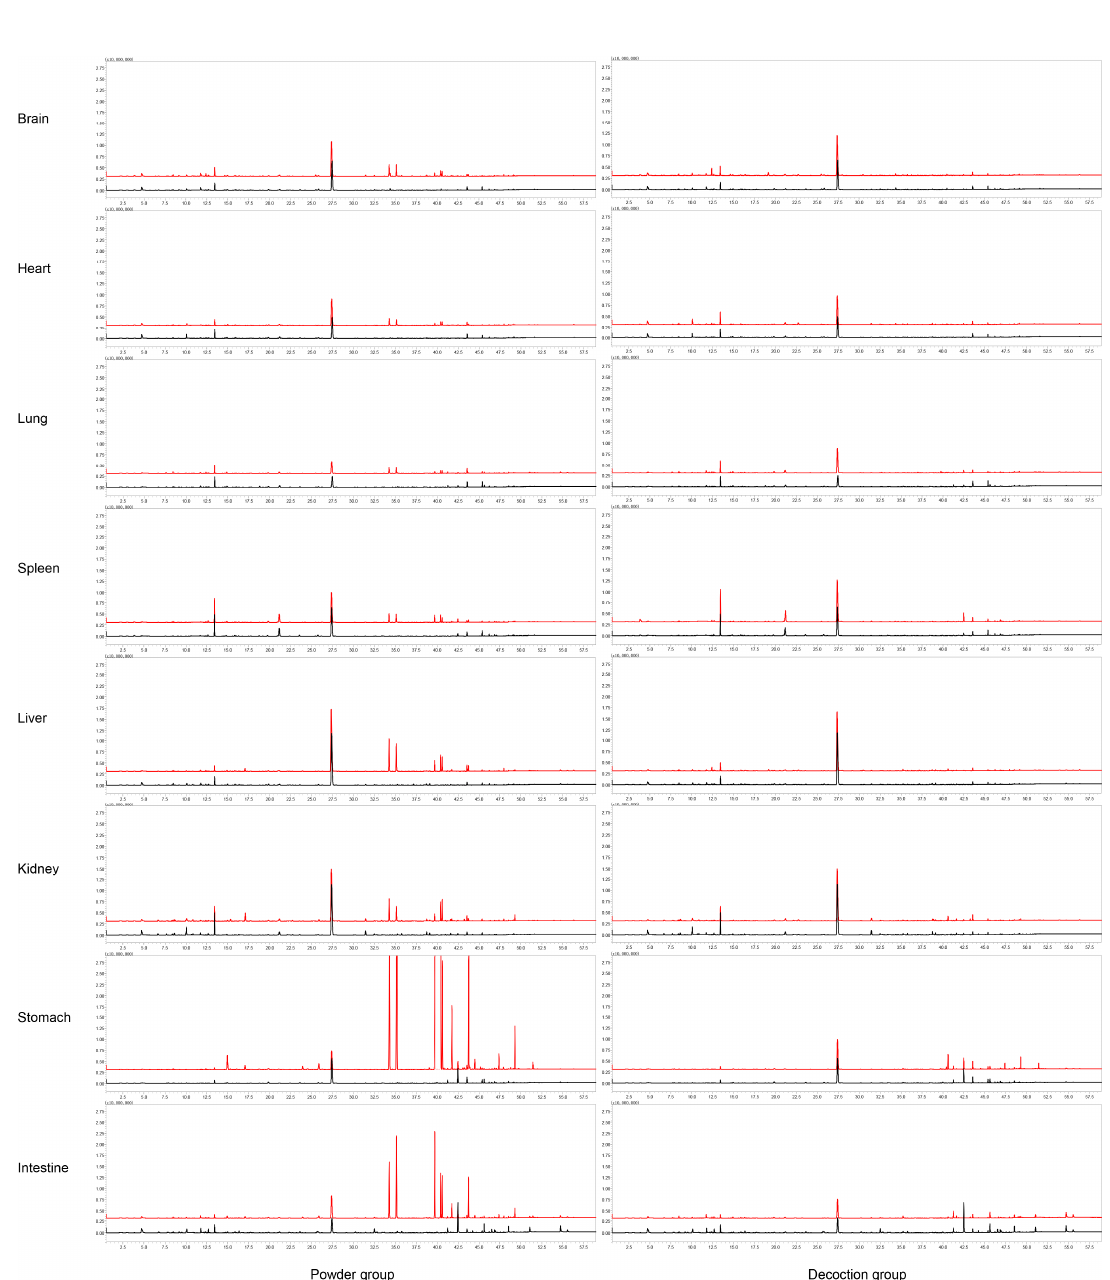
Figure 2. Total ion chromatograms (TICs) of compounds identified in brain, heart, lung, spleen, liver, kidney, stomach, and small intestine of rats after oral administration of ARR powder or decoction by HS–SPME–GC–MS. Red line: treatment group; black line: control group.